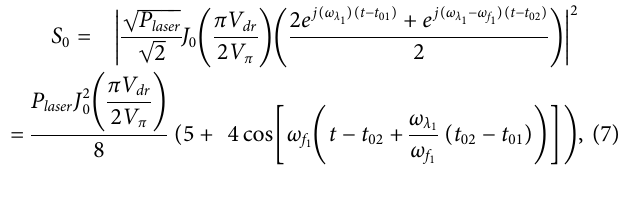
Frontiers in Communications and Networks |